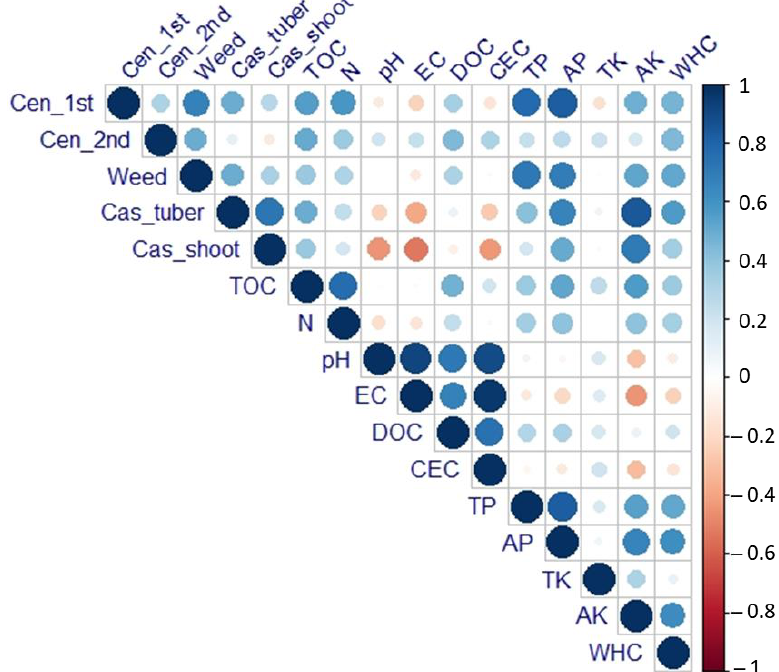
Figure 3. Heat map showing the relationships among crop yields and some soil physicochemical properties at harvest time. The color gradient represents Pearson correlation coefficients when significant ( n = 24, p < 0.05).